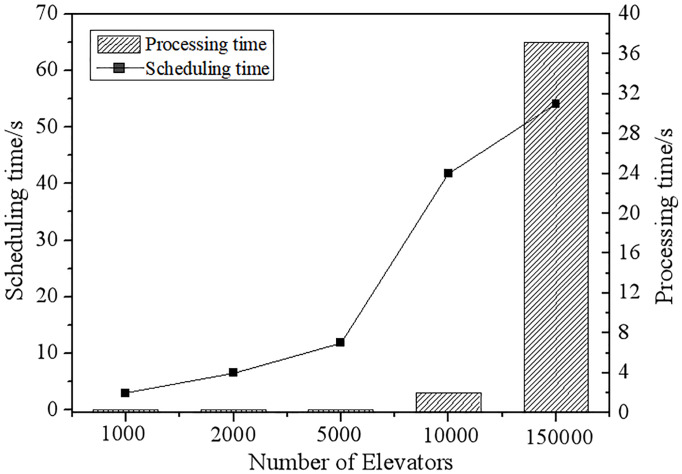
Monitoring of the delay and processing time of different numbers of elevators.